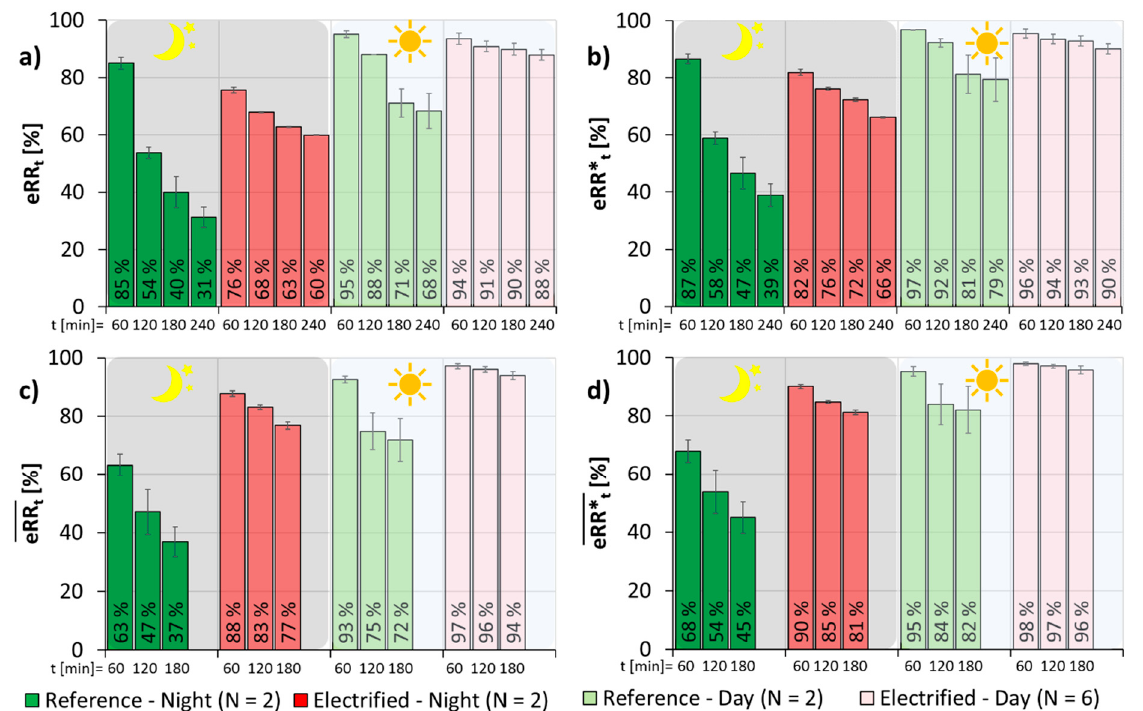
Figure 5. Average experimental retention rates eRR t [%] depending on the evaluation duration t [min] distinguished by treatment conditions and day-time based on ( a ) the number of participating fish (detection antenna A1) without exclusion of initial effects (first hour of the trials) eRR t , ( b ) the number of stocked fish without exclusion of initial effects eRR ∗ t , ( c ) the number of participating fish with exclusion of initial effects eRR t and ( d ) the number of stocked fish with exclusion of initial effects eRR ∗ t . Error indicators mark lower and upper boundaries in performed